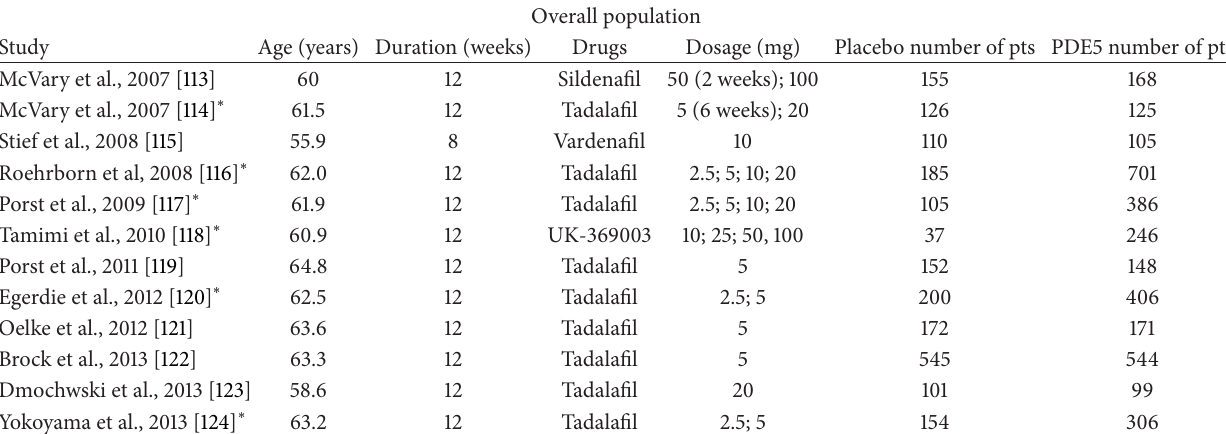
Table 2: Characteristics of the studies included in the meta-analysis. Overall